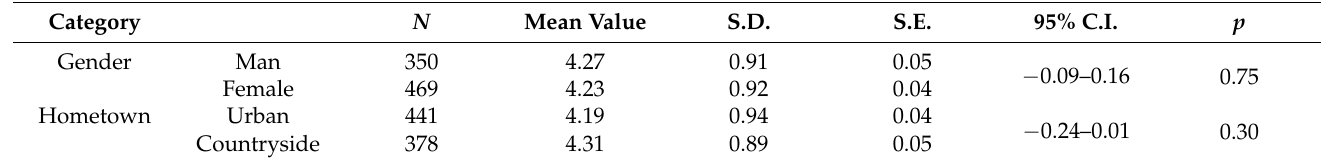
Table 1. T -test on population information.